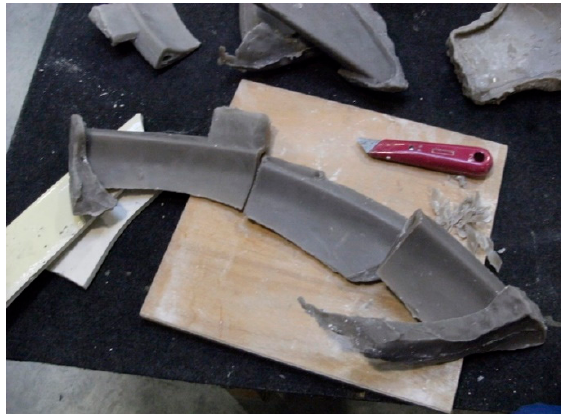
Figure 7. Matthias. 2014. Wax models taken from the inside of broken sinks.